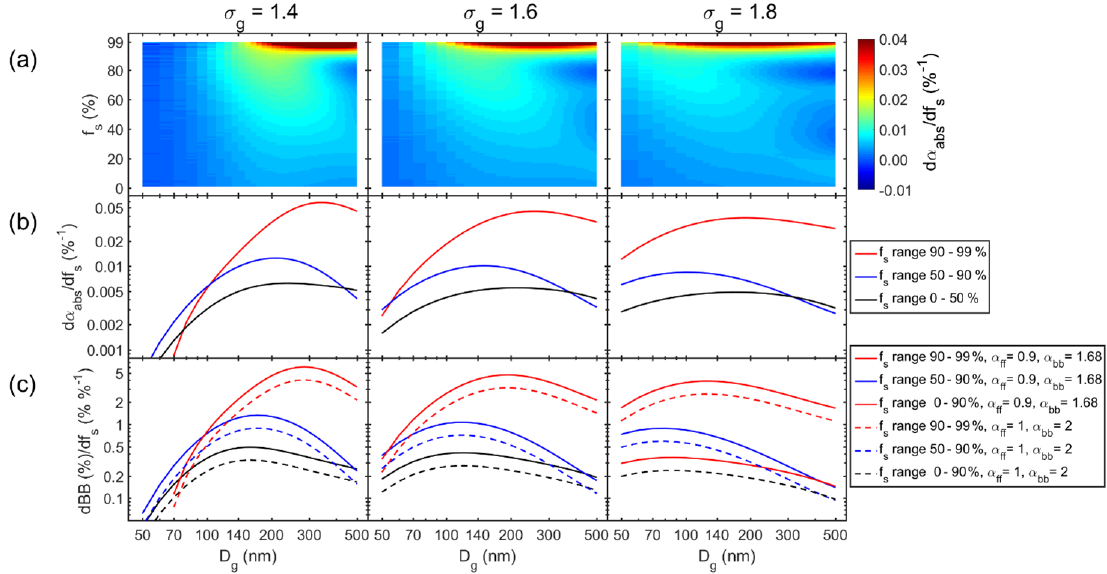
Figure 7. Size-dependent sensitivity of α abs and BB(%) to variations of the shell volume fraction f s . (a) α abs sensitivity in the whole f s range of 1%–99%, (b) average α abs sensitivity in three f s ranges, and (c) average BB(%) sensitivities in three f s